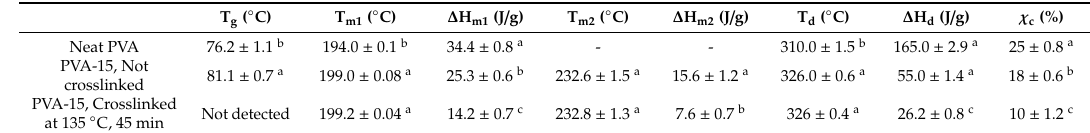
Figure 6. Di ff erential scanning calorimetry (DSC) thermograms for the prepared NCFs. Figure 6. Differential scanning calorimetry (DSC) thermograms for the prepared NCFs. Table 1. Analysis results from DSC measurements